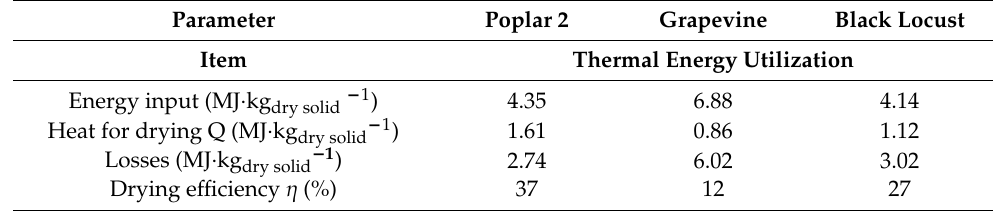
Table 6. Thermal energy balance (average data for each drying